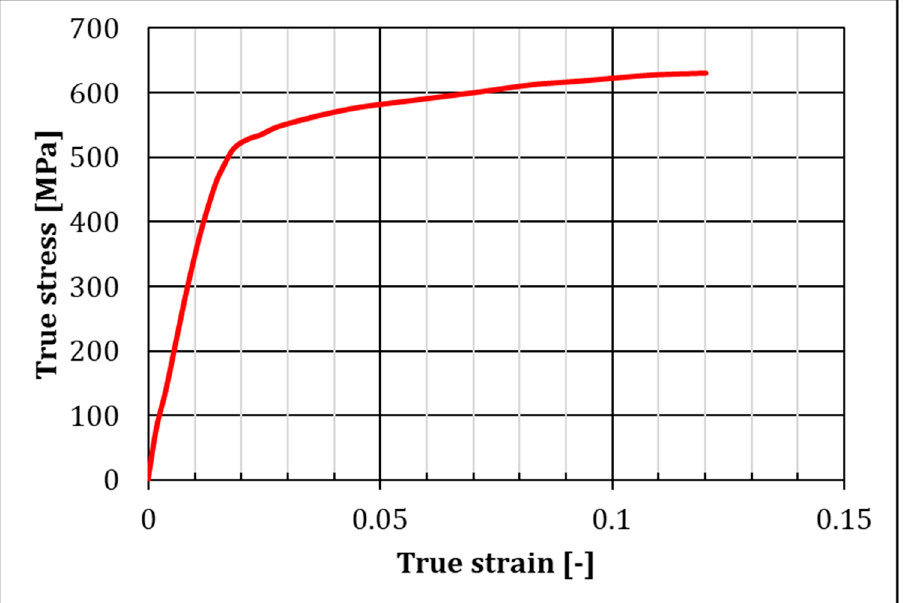
Figure 3. CAD model of the steel pipe rapired with a composite sleeve.